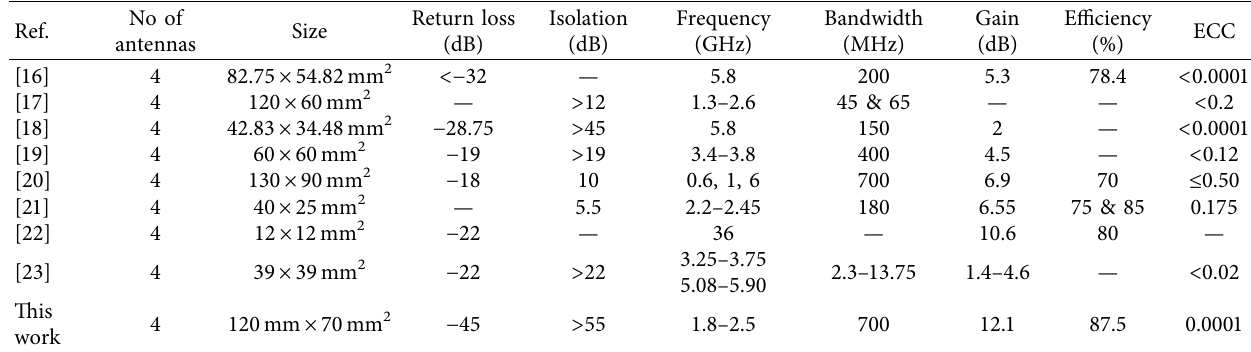
Table 4: Comparison of the proposed MIMO antenna with reported antenna. Ref.